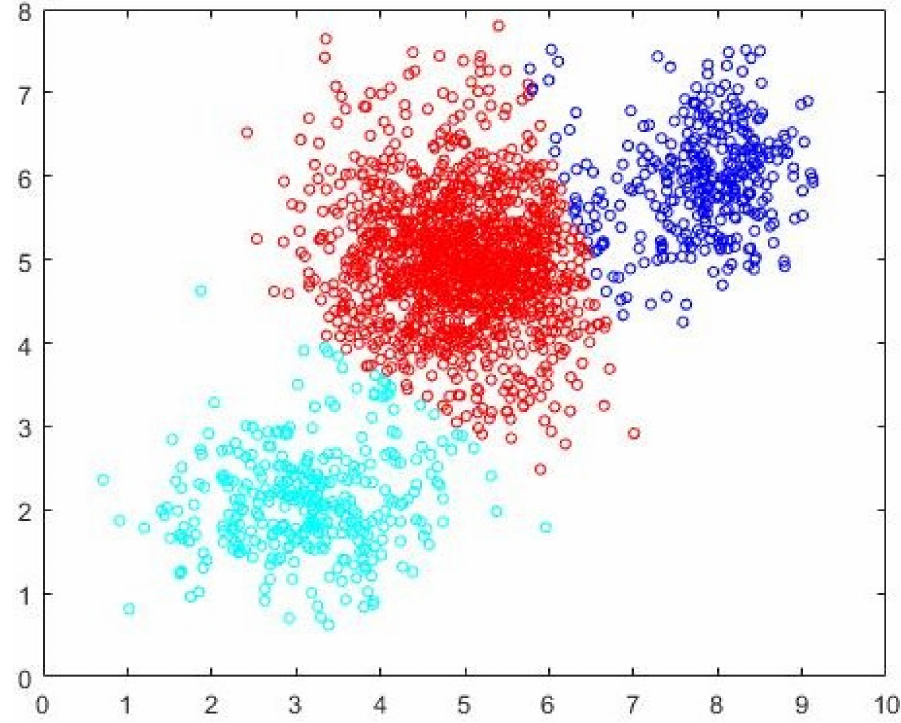
Figure 9. Partition by FCM-AO, c = 3 with randomly initialized cluster